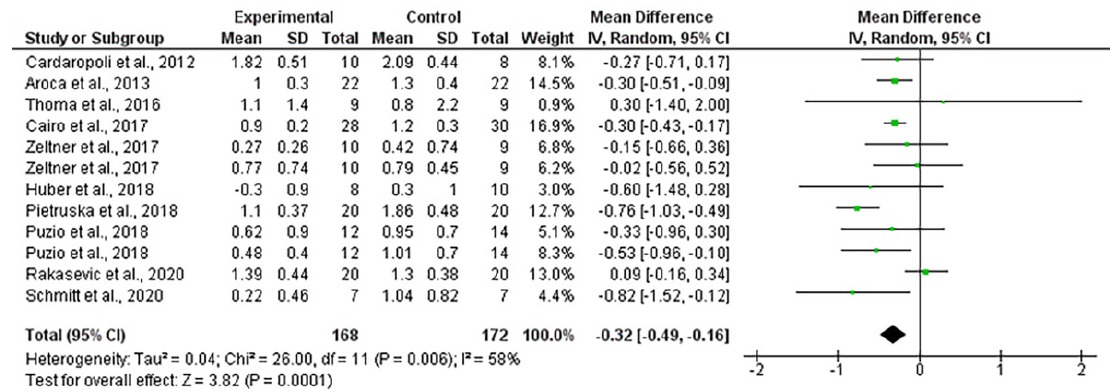
Figure 11. ( a ) Funnel plot for gingival thickness in control group (autogenous connective tissue). The estimated gingival thickness measurement is on the horizontal axis and the study precision (standard error) appears on the vertical axis. ( b ) Funnel plot for gingival thickness in the test group (collagen matrix). The estimated gingival thickness measurement is on the horizontal axis and the study precision (standard error) appears on the vertical axis.